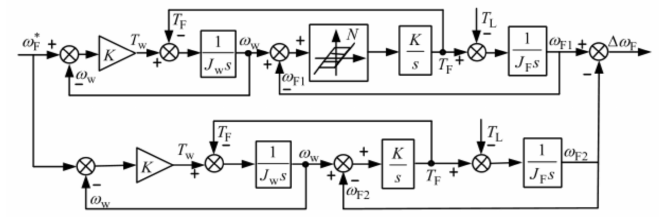
Figure 7. Experimental system of verifying nonlinear clearance